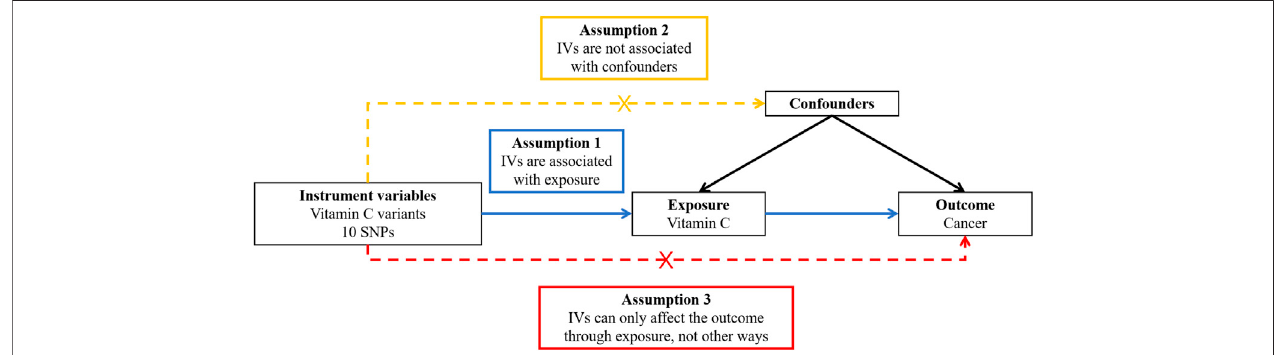
FIGURE 1 | Overview of the design and three key assumptions of the Mendelian randomization study. IVs, instrument variables; SNPs, single-nucleotide